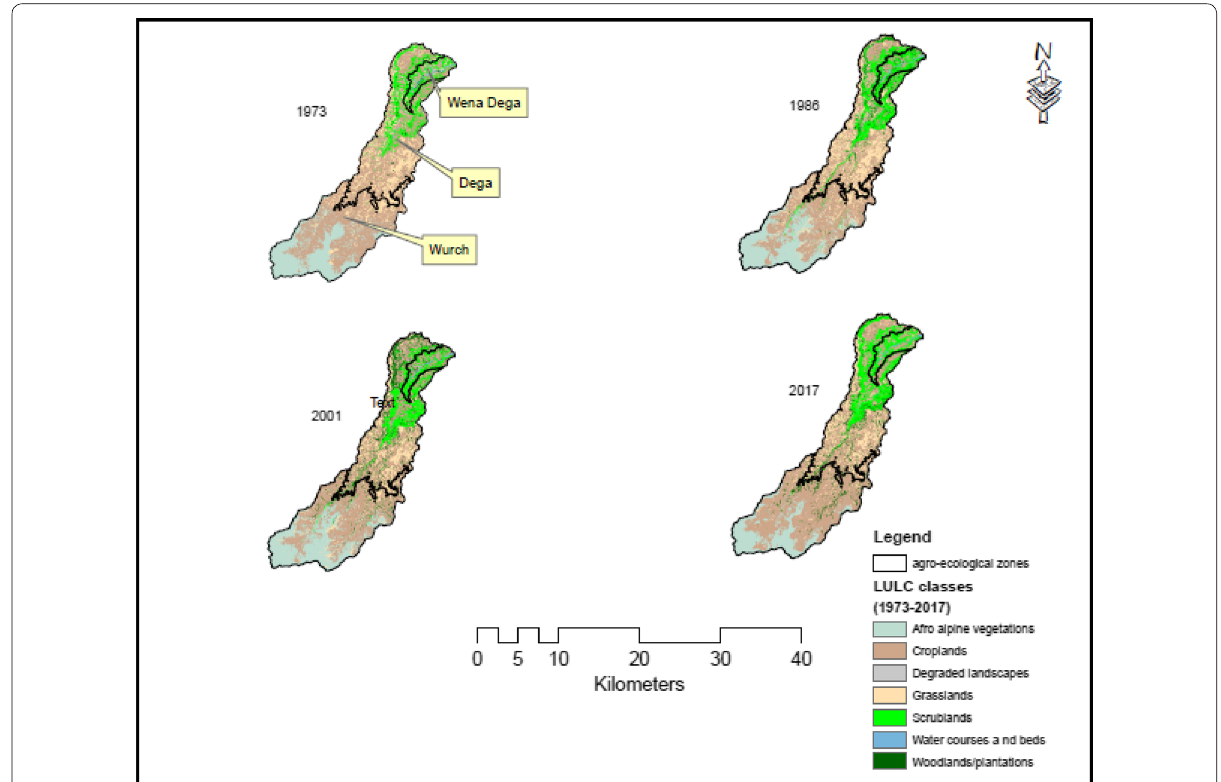
Fig. 8 Map depicting land use/cover distribution along agro ecology (1973–2017)